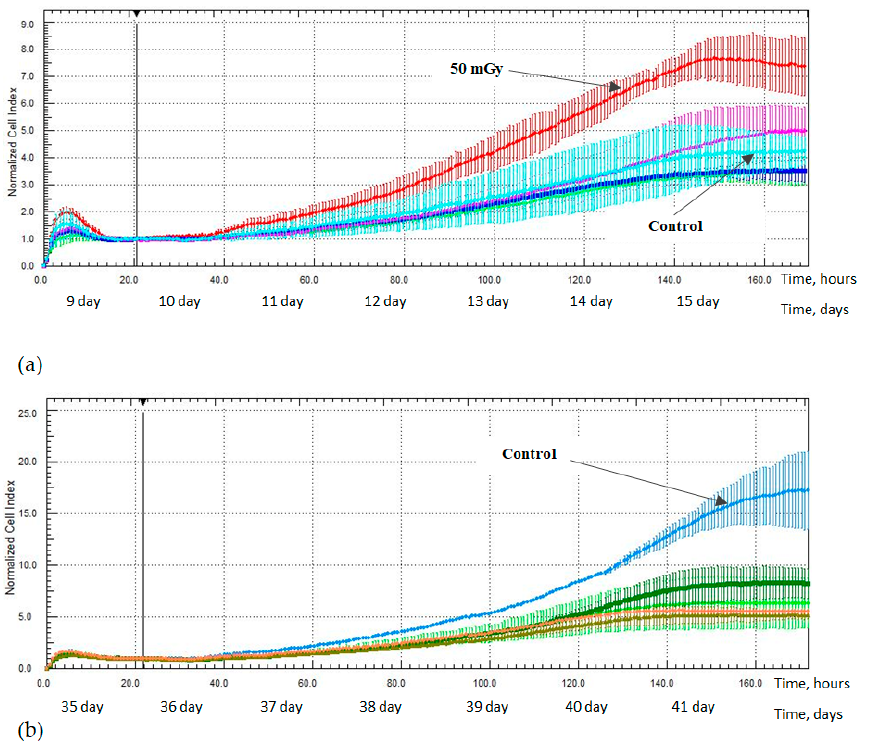
Figure 8. The proliferative activity of MSCs (n = 3): ( a ) from 9 days after irradiation at doses of: 50 mGy (red) and 100 mGy (pink), 250 mGy (green) and 1000 mGy (blue); ( b ) from 35 days after irradiation at doses of: 50 mGy (light green) and 100 mGy (dark green), 250 mGy (green) and 1000 mGy